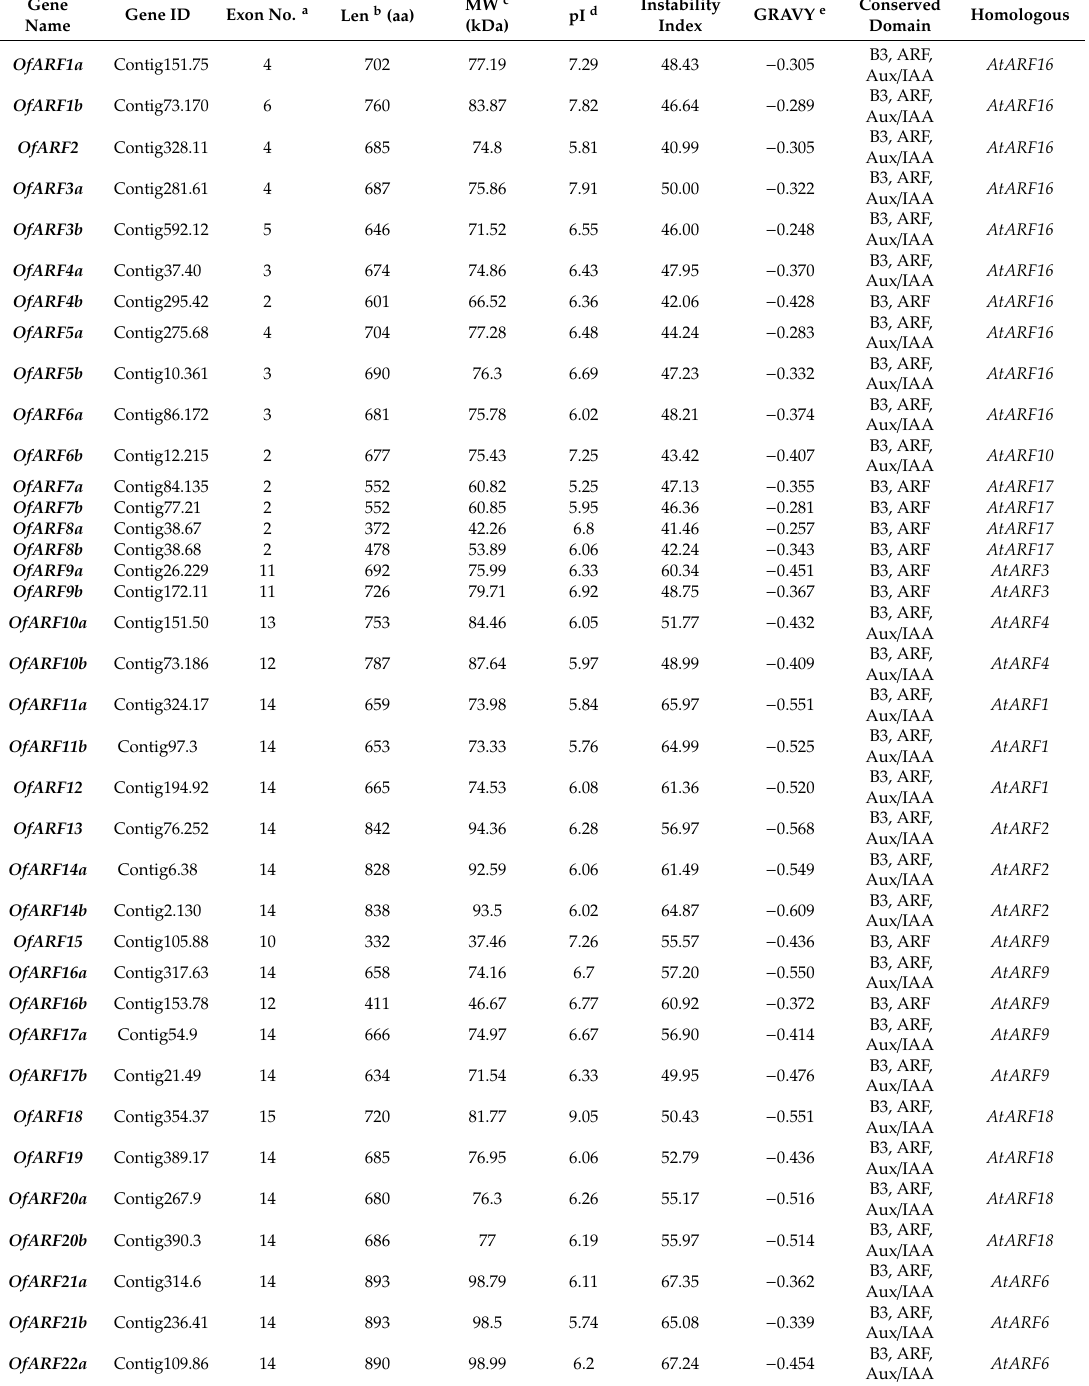
Table 1. Osmanthus fragrans auxin response factor ( OfARF) genes encoding auxin response factor (ARF) proteins, along with the gene and protein molecular